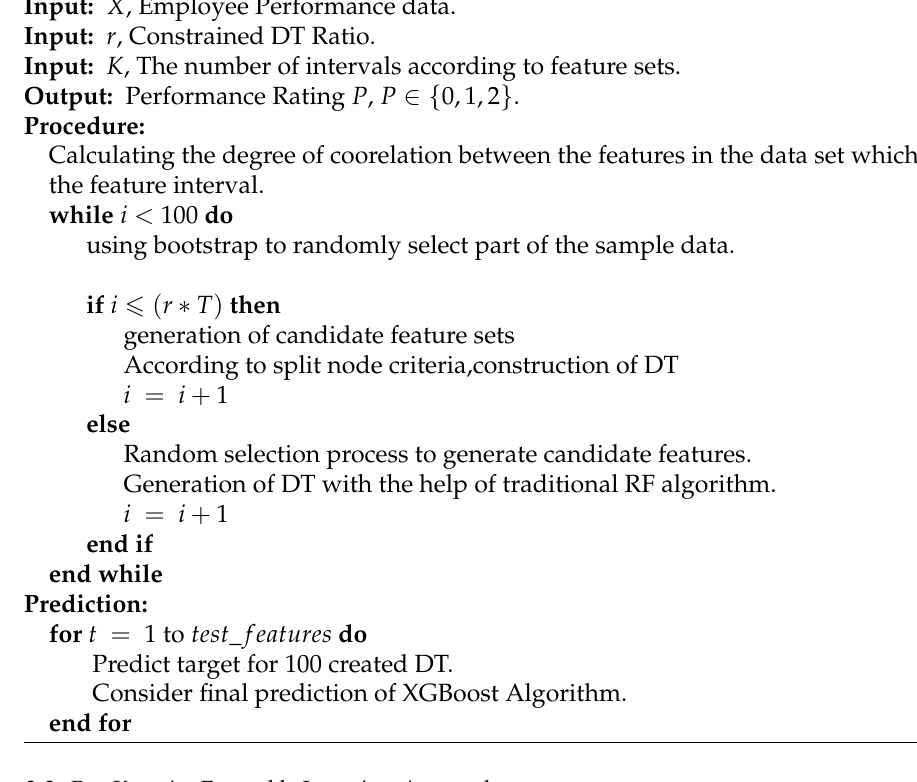
Algorithm 1 XGBoost